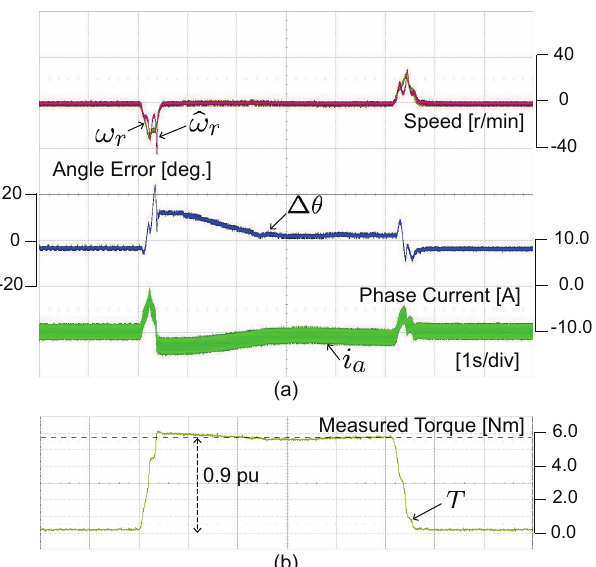
Figure 10. Zero speed under no load condition. Control performance under 0.9 pu load: ( a ) speed, angle error, a -phase current, and ( b ) load